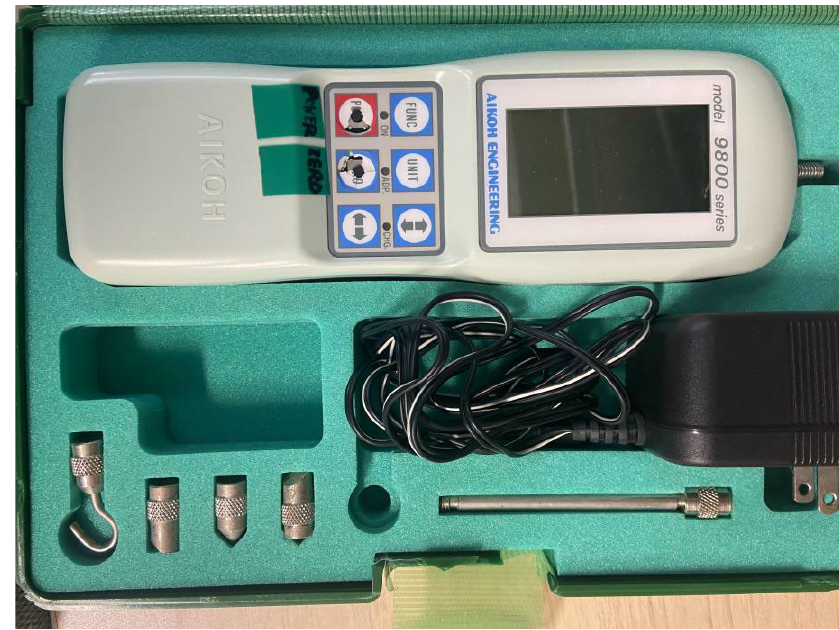
Figure 19. Force gauge AIKOH Model 9800 Series. Table 3. Step overcoming force of the wheel state according to the height of the step.